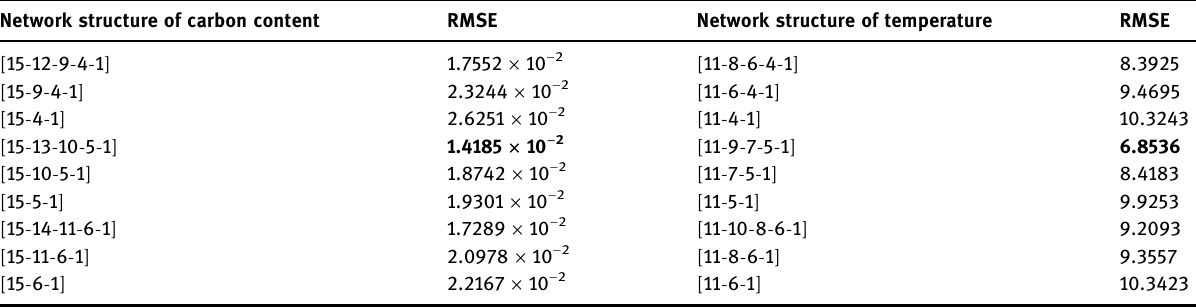
Table 4: Prediction performance of some candidate schemes of network parameters under the method of this paper Network structure of carbon content